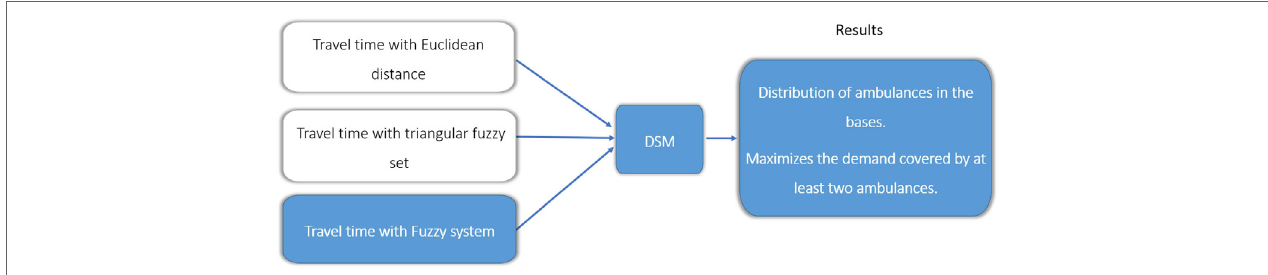
FigUre 1 | Different methods used to estimate the ambulance travel times for the double standard model